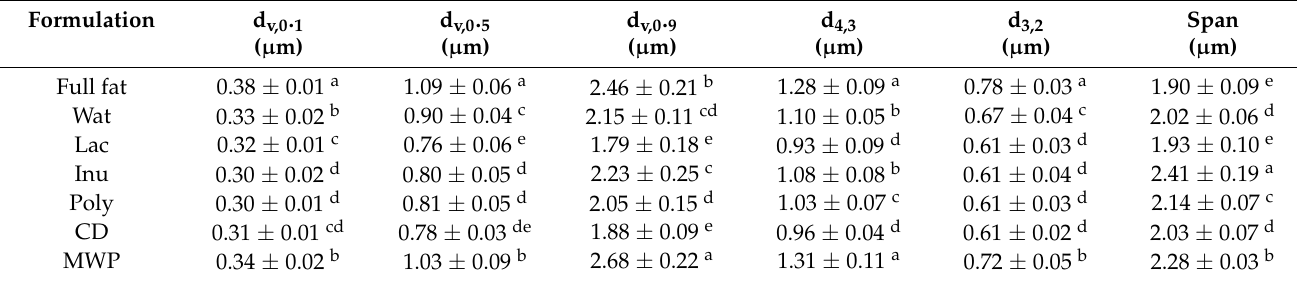
Table 5. Metrics of the particle size distribution for all emulsion